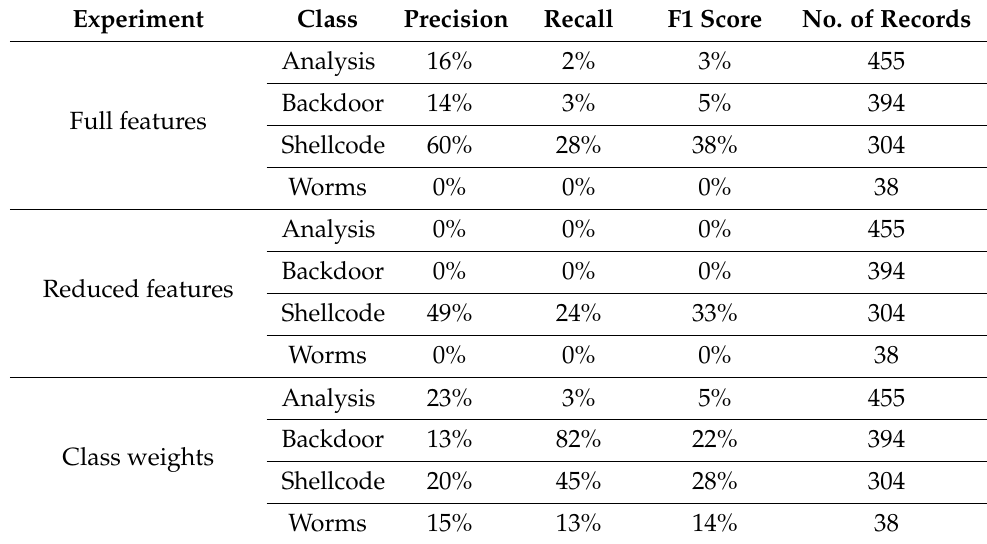
Table 25. Performance metrics for minority classes in UNSW-NB15 multiclass